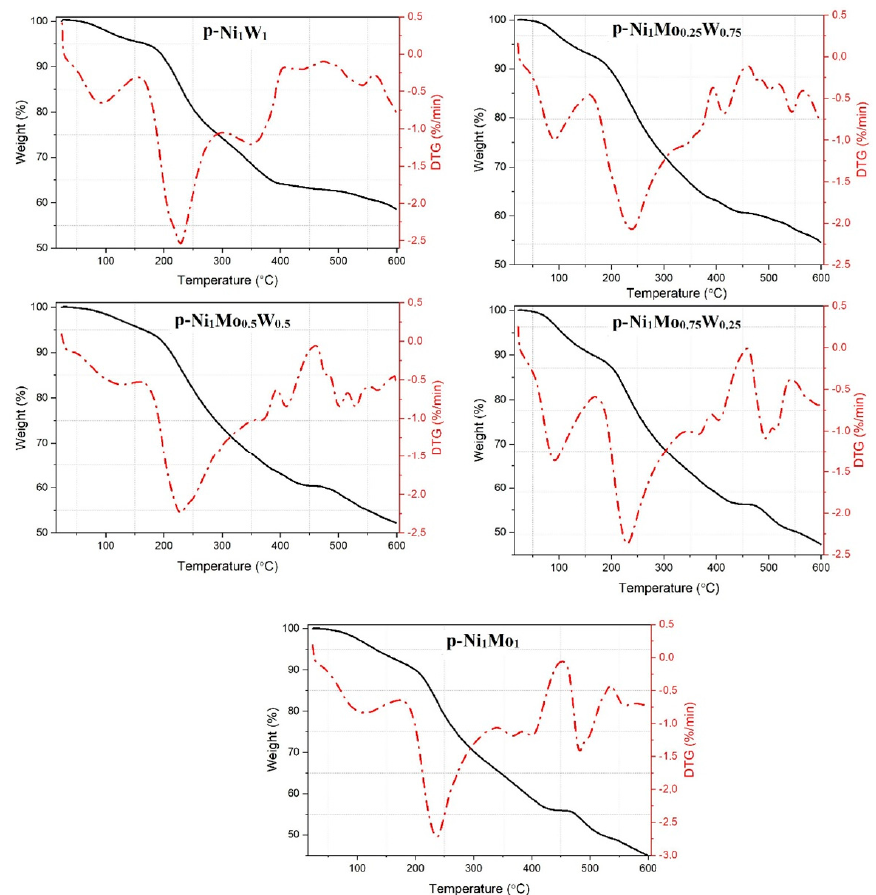
Figure 1. TG and DTG curves of p—Ni 1 W 1 , p—Ni 1 Mo 0.25 W 0.75 , p—Ni 1 Mo 1 , p—Ni 1 Mo 0.75 W 0.25 , and p—Ni 1 Mo 0.5 W 0.5 powders.